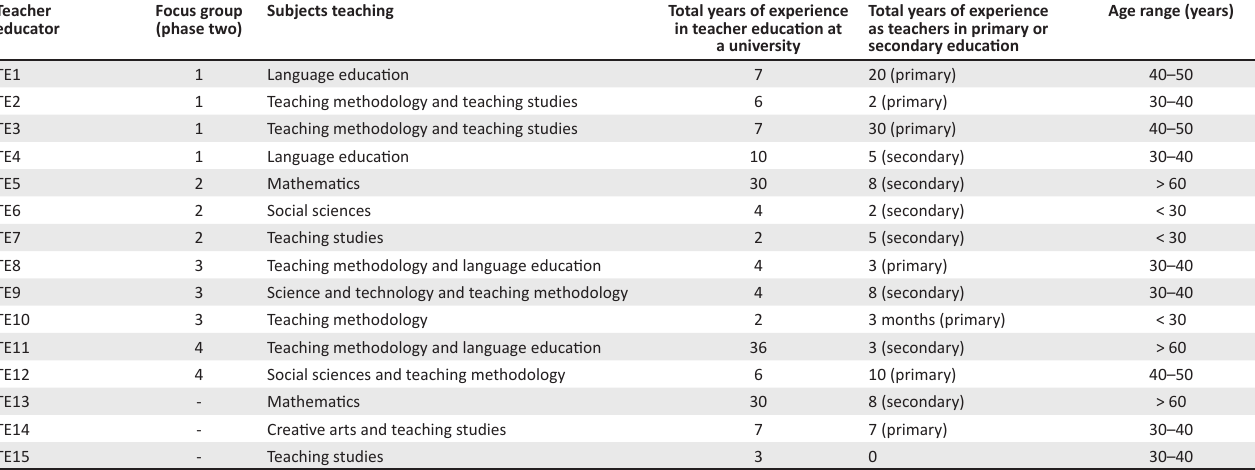
TABLE 1: Demographic details of teacher educators participating in